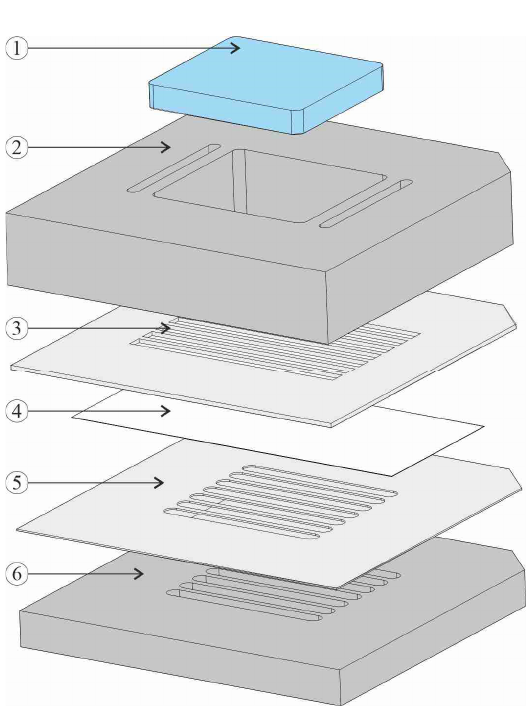
Figure 4. A schematic diagram showing the individual components of the test section, 1—glass plate, 2—channel body, 3, 5—spacers, 4—heated foil, 6—front cover. 2—channel body, 3, 5—spacers, 4—heated foil, 6—front